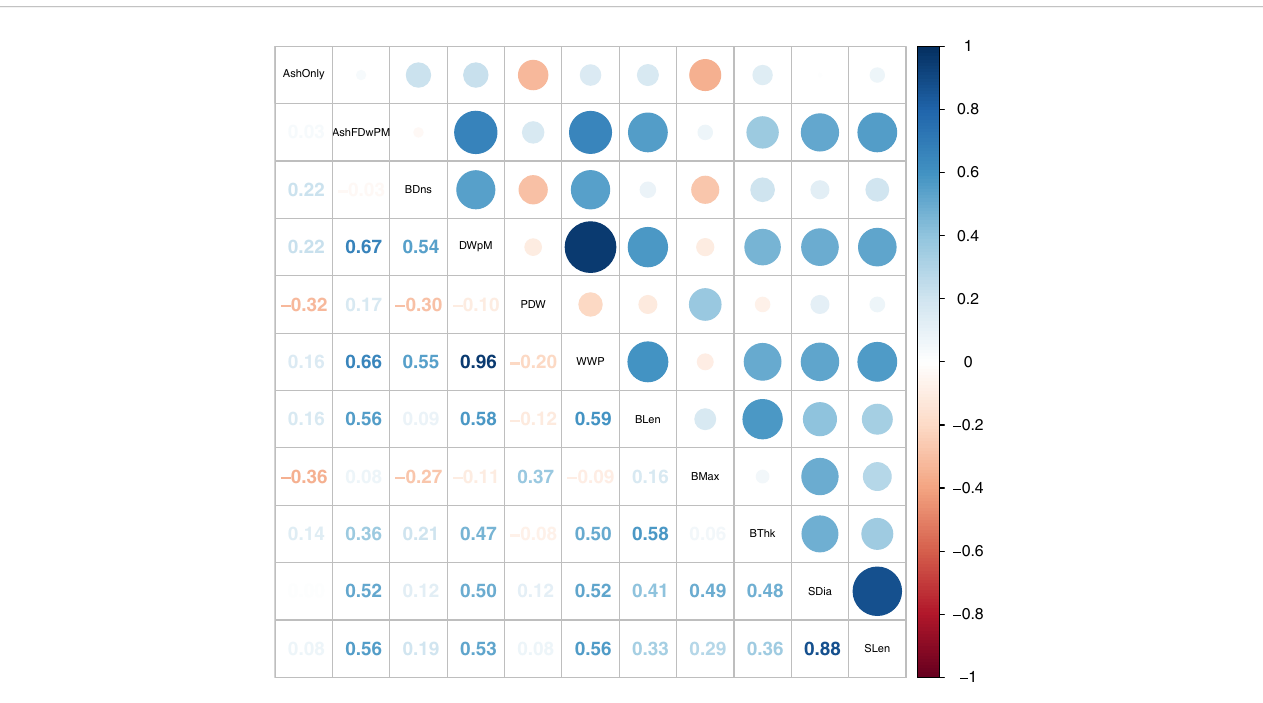
Yr2020) when prediction accuracy was higher without than with marker information (Table 3). The trend for GS within-year prediction accuracy was similar to that for heritability values across traits in that (and higher heritability) than yield-related traits (Tables 1, 3). We compared the variance within each year due to female parents (GCA_FG) with those due to male parents (GCA_MG) using the